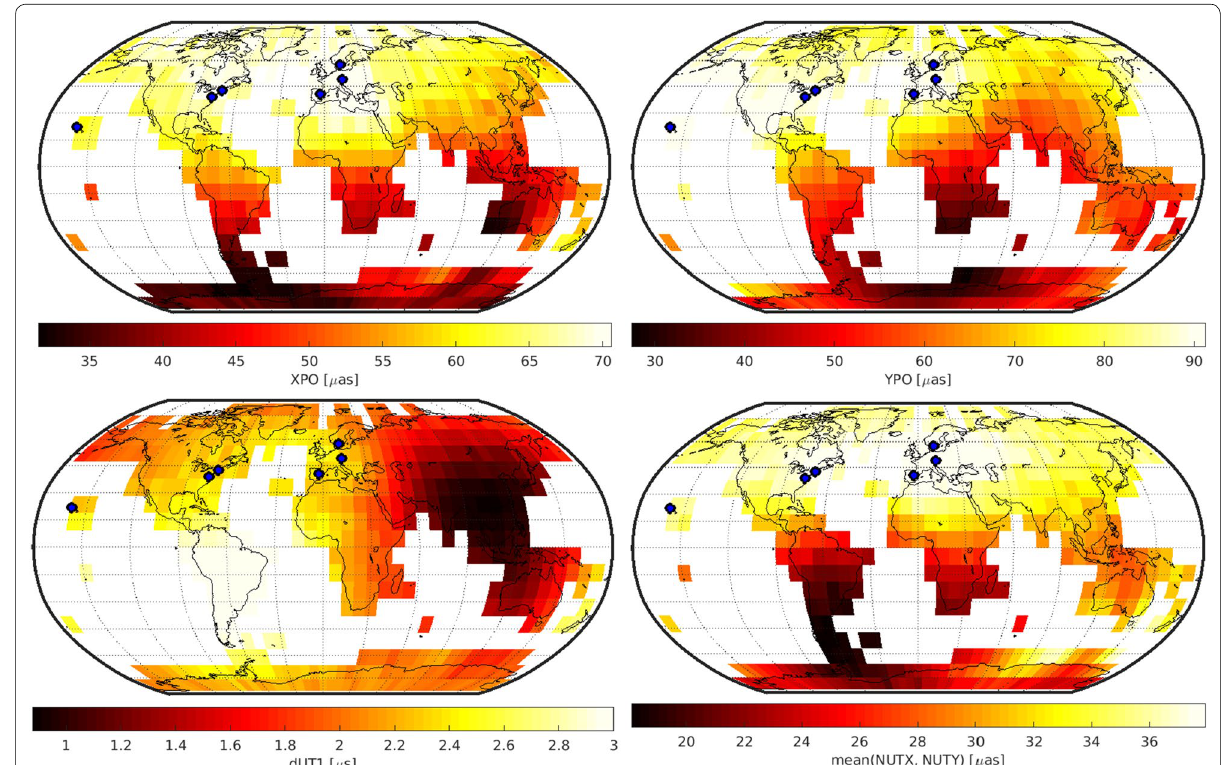
Fig. 3 Precision of geodetic parameters for the 6